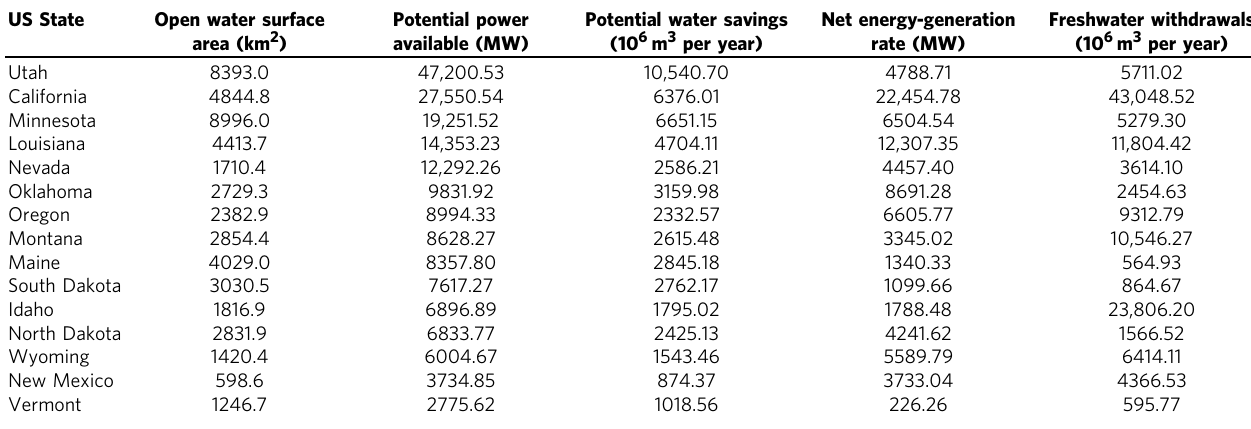
Table 1 US States where the potential power available due to evaporation from open water surface area exceeds the net energy generation